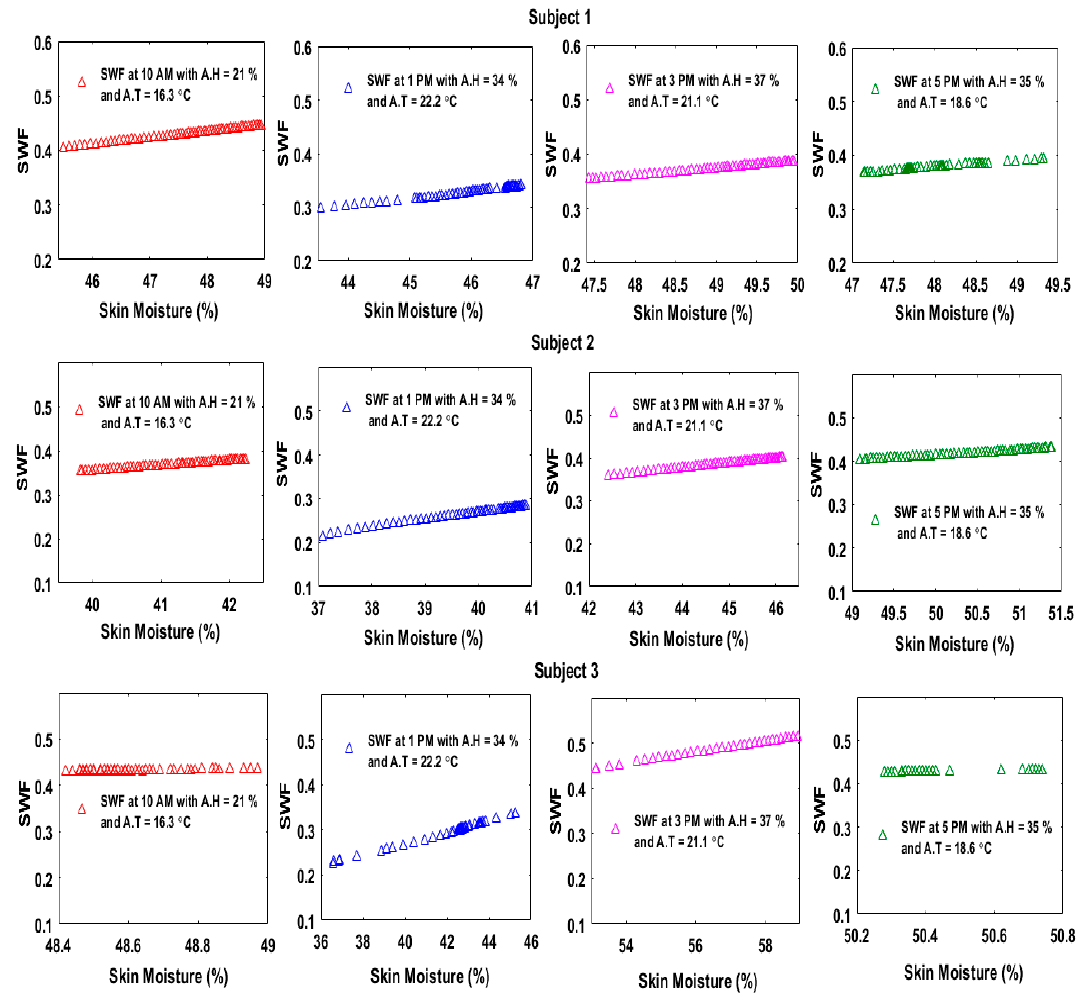
ff erent times of the day during the outdoor Figure 12. SWF of three subjects at different times of the day during the outdoor experiment. Figure 12. SWF of three subjects at di